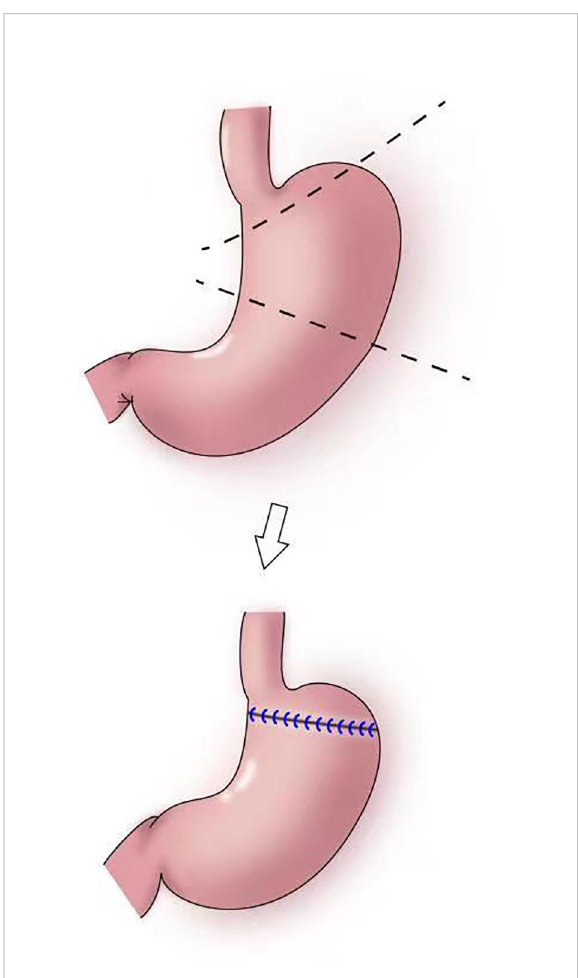
FIGURE 7 Segmental gastrectomy: The shaded area of the stomach is excised in upper fi gure. Anastomosis is performed between the distal remnant of the stomach and a fundic pouch in lower fi